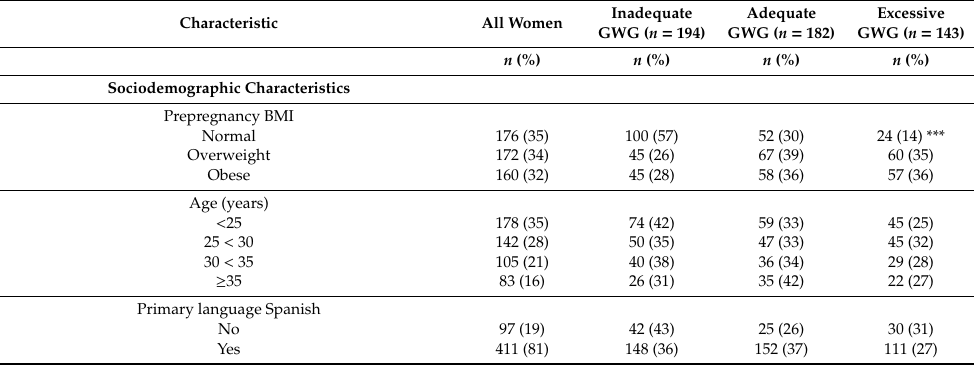
Table 2. Distributions of sociodemographic characteristics, health behaviors, and psychosocial stressors among low-income Hispanic women participating in the Starting Early Obesity Prevention Study, stratified by gestational weight gain adequacy ( n =